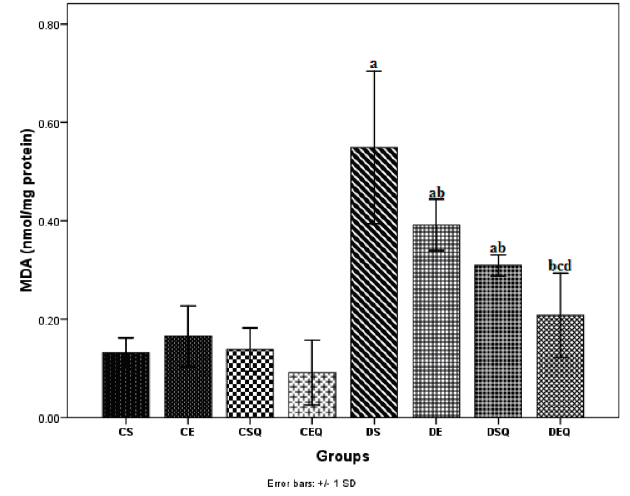
Figure 1. The effects of quercetin and moderate exercise training on lipid peroxidation (MDA) (nmol/mg protein) levels in the thoracic aortic tissue homogenates of control and diabetic rats. Results are the means ± SD for ten animals in each group in the CS (non-diabetic sedentary untreated control rats), CE (non-diabetic trained untreated control rats), CSQ: (non-diabetic sedentary control rats treated with quercetin), CEQ (non-diabetic trained control rats treated with quercetin), DS (diabetic sedentary control rats), DE (diabetic trained untreated control rats), DSQ (diabetic sedentary rats treated with quercetin), DEQ (diabetic trained rats treated with quercetin) groups. Statistically significant differences are indicated by the symbols: a p < 0.05 vs. CS group, b p < 0.05 vs. DS group, c p < 0.05 vs. DE group and d p < 0.05 vs. DSQ